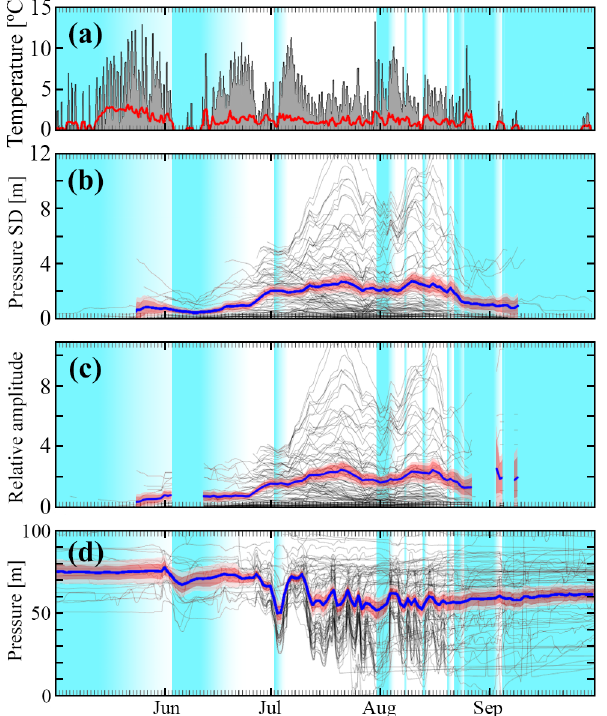
Figure 12. Relative amplitudes of pressure and temperature diurnal oscillations from May to September 2015. (a) Positive air tempera- ture (grey), and its standard deviation over a 1-day running window (red). (b) Standard deviation of pressure over a 1-day running win- dow (thin black lines) for each borehole in the plateau area, and the mean of these standard deviations (blue) with bootstrap confi- dence intervals of 90% (dark pink) and 99% (light pink). (c) Ra- tio between pressure and temperature standard deviations shown in panels (a) and (b) , computed only where standard deviation of air temperature is non-zero. (d) Mean pressure computed over a 1-day running window. Light blue shading represents fresh snow on the glacier surface.